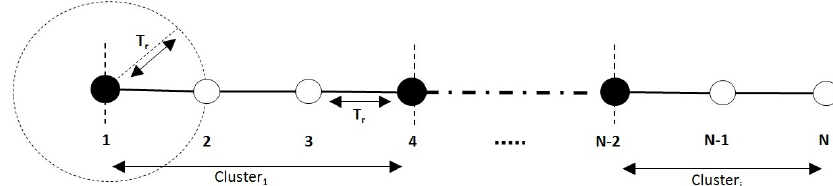
Figure 11. Worst-case scenario ( k =